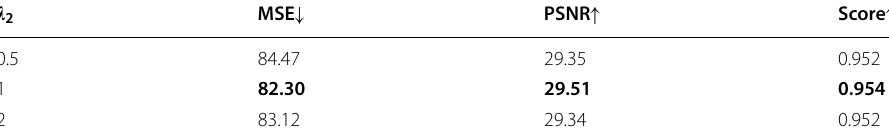
Bold values indicate the best results